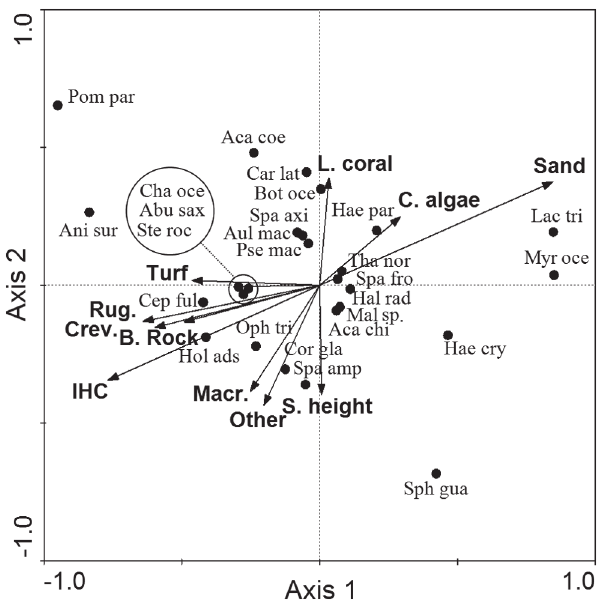
Fig. 3. Canonical plotting of microhabitat characteristics (arrows) and fish species (points). Rug.: rugosity; Crev.: number of crevices; S. height: substratum height; C. algae: percent cover of encrusting coralline algae; Macr.: percent cover of Macroalgae; Turf: percent cover of turf algae; L. coral: percent cover of live coral; Other: percent cover of other organisms; B. rock: percent cover of bare rock; Sand: percent cover of sand and limestone; IHC: index of habitat complexity; Species names are abbreviated as the first three letters of genus and first three letters of specific epithet (see Table 4 for full scientific names).